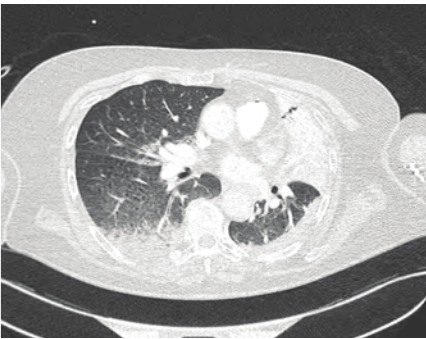
Figure 2: Axial section CT image of the thorax. Bilateral consol- idative change with air bronchogram, more extensive within the left